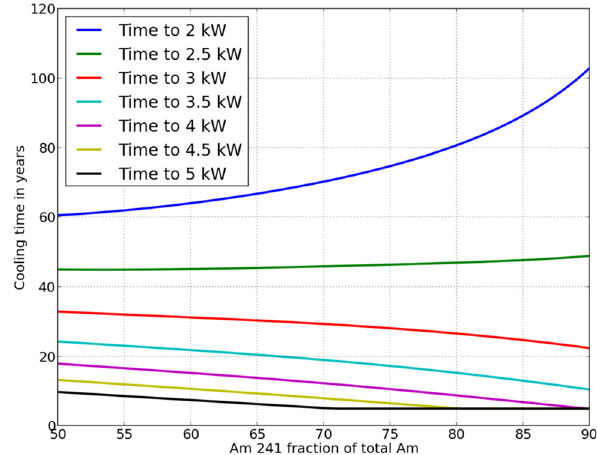
Fig. 1. Evolution of the various contributions to total decay heat versus time.